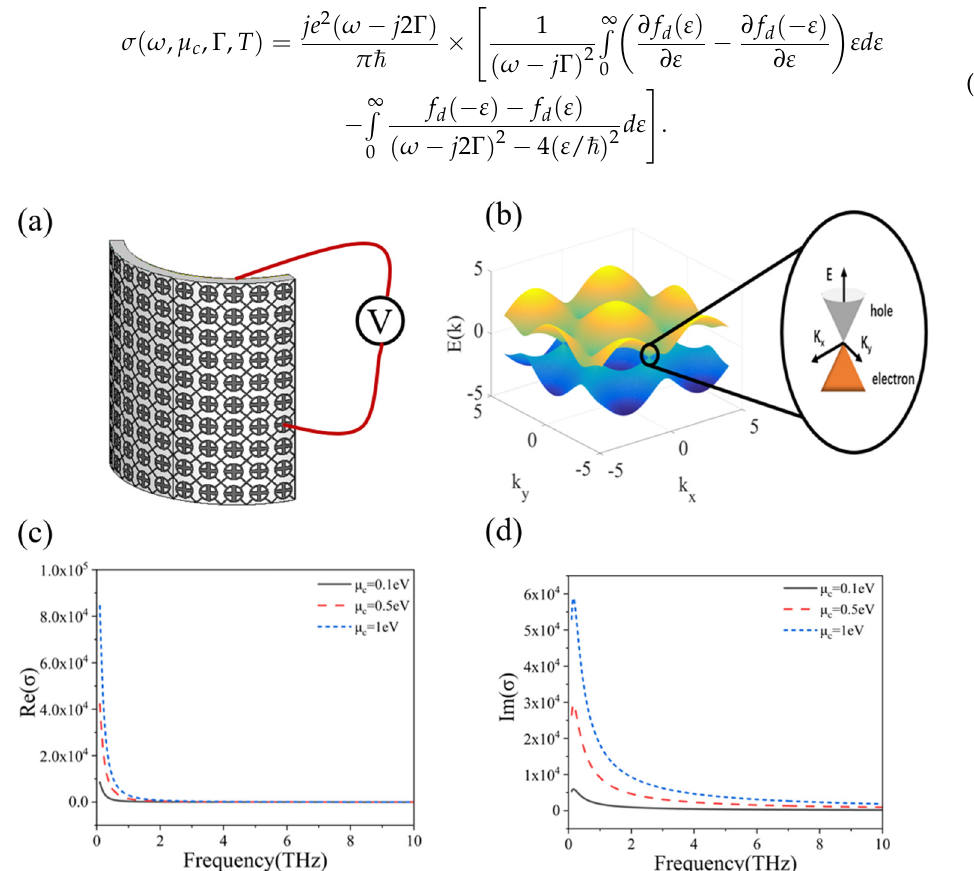
Figure 3. ( a ) Three-dimensional schematic diagram of the flexible graphene tunable metamaterials; ( b ) Schematic diagram of graphene band gap; ( c ) Trends of real part of graphene conductivity with chemical potential and frequency; ( d ) Trends of imaginary part of graphene conductivity with chemical potential and frequency.